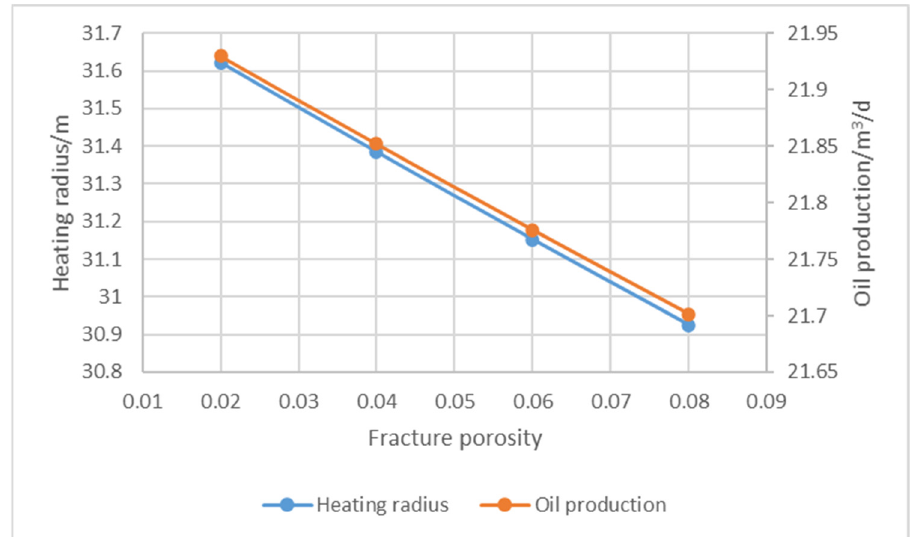
Figure 5. The influence of fracture porosity on production and heating radius.